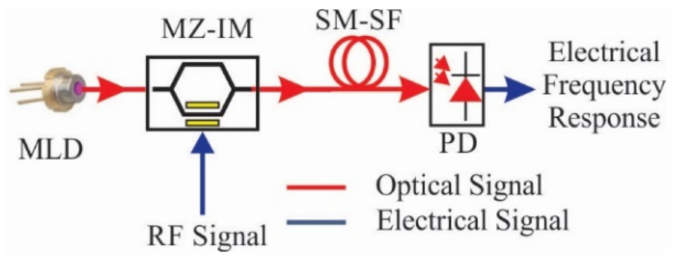
Figure 2. Basic scheme of the passband MPF used in this work.